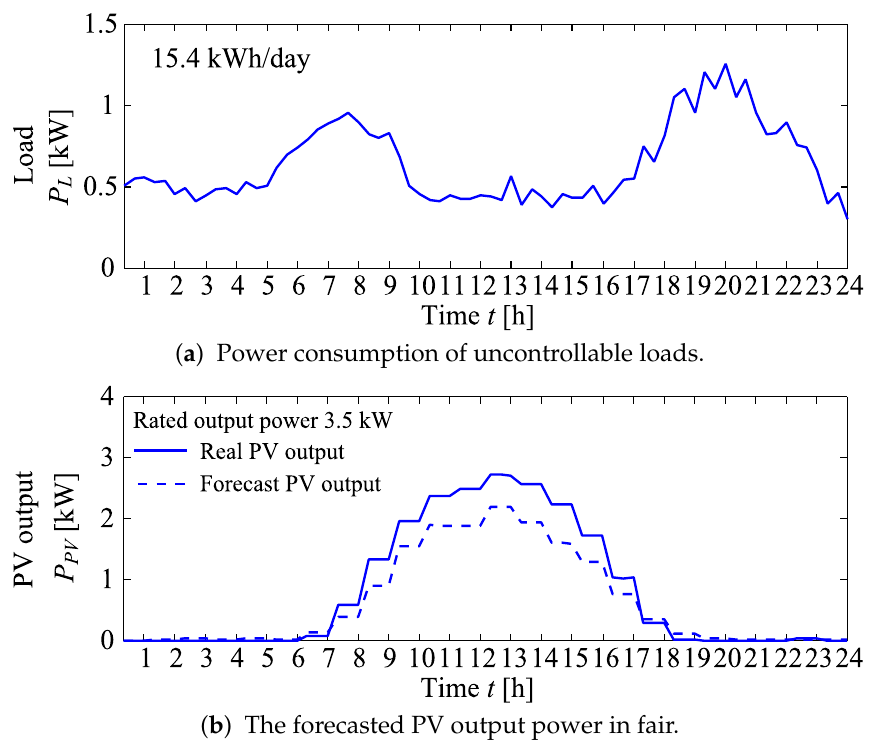
Figure 7. Power consumption and PV output